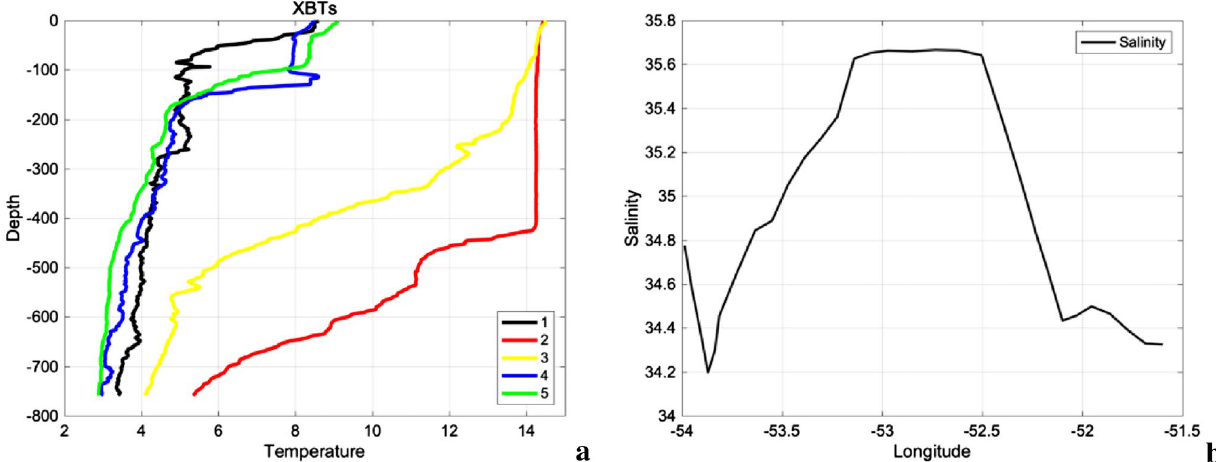
Figure 2. Synoptic, in situ measurements taken along Brazilian Navy Polar Vessel (Po/V) Almirante Maximiano (H-41) route while crossing the eddy. (a) XBT temperature (°C) depth profiles. The numbers in the legend denote de XBT positions, with 1 being the westernmost position and 5 being the easternmost position. The number 2 (red) is closest to the eddy core position. (b) Salinity, measured by ship